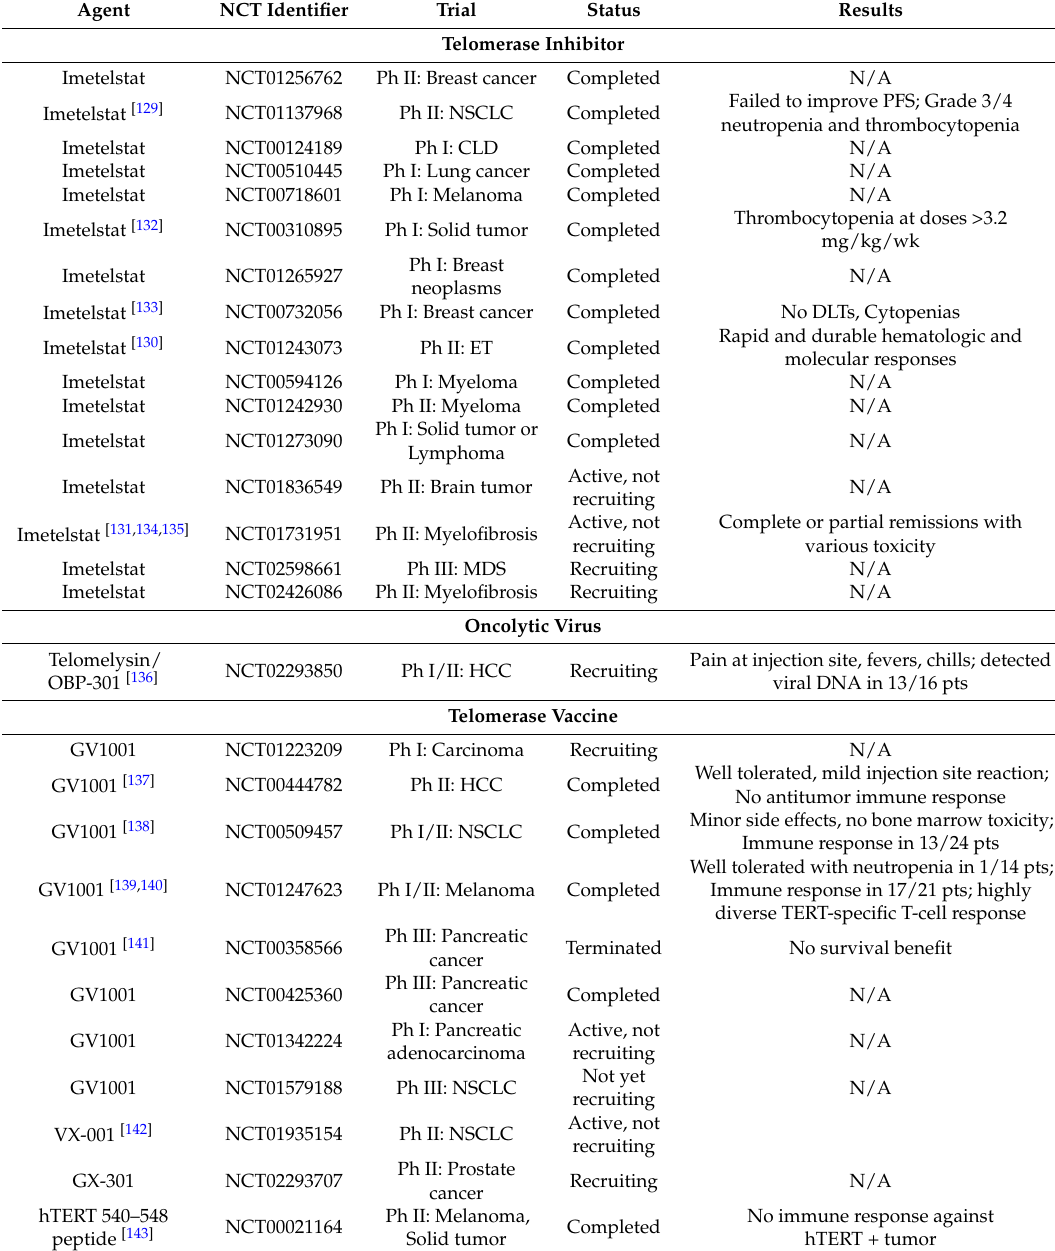
Table 1. Telomerase therapeutics currently in clinical